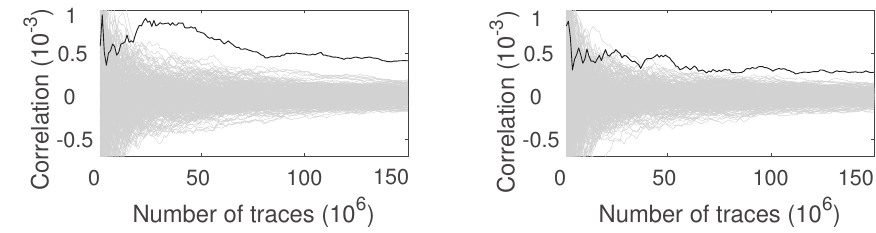
Figure 11: Exemplary CPA attack results exploiting the power